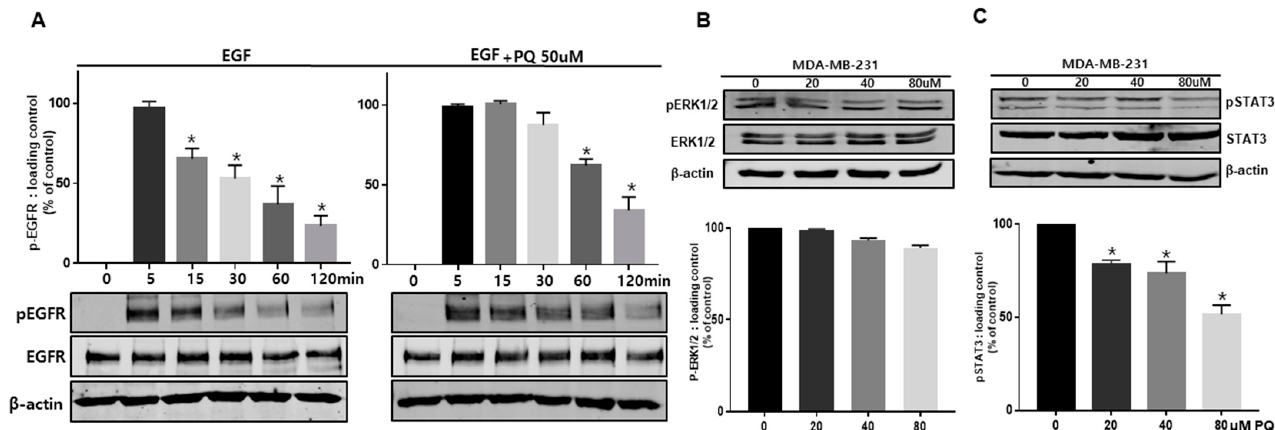
Figure 4. Primaquine treatment delayed EGFR signaling and reduced Stat3 signaling. ( A ) MDA-MB-231 cells were exposed to DMSO or 50 µ M primaquine for 24 h and then treated with EGF from 0 to 120 min. Cells were finally lysed and proteins were identified with anti-pEGFR and anti-EGFR antibodies by Western blotting. ( B ) MDA-MB-231 cells were exposed to DMSO or 20, 40, and 80 µ M primaquine for 24 h. Cancer cells were finally lysed and proteins were identified with anti-pERK1/2 and anti-ERK1/2 antibodies by Western blotting. ( C ) MDA-MB-231 cells were exposed to DMSO or 20, 40, and 80 µ M primaquine for 24 h. Cancer cells were finally lysed and proteins were identified with anti-pStat3 and anti-Stat3 antibodies by Western blotting. The data are presented as the mean ± SD; n = 3; * indicates p < 0.05 vs. control.